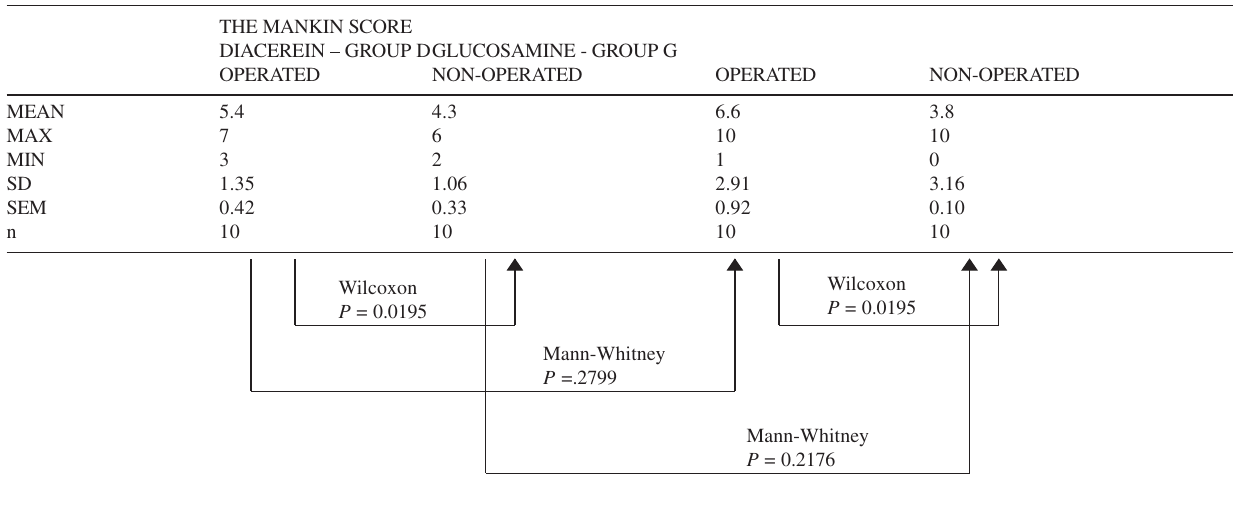
Table 3 - Evaluation by the Mankin score THE MANKIN SCORE DIACEREIN – GROUP DGLUCOSAMINE - GROUP